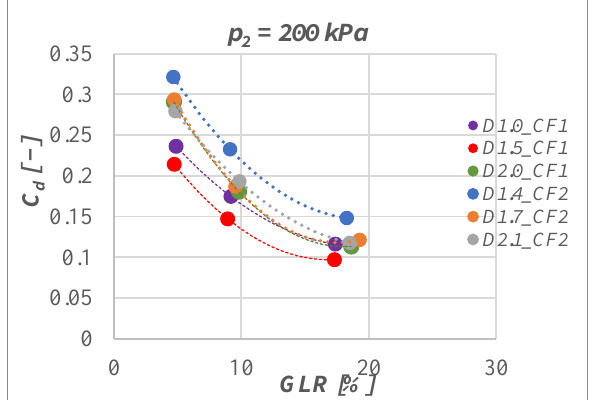
Fig. 12. The influence of GLR on SCA for p 2 = 100 kPa